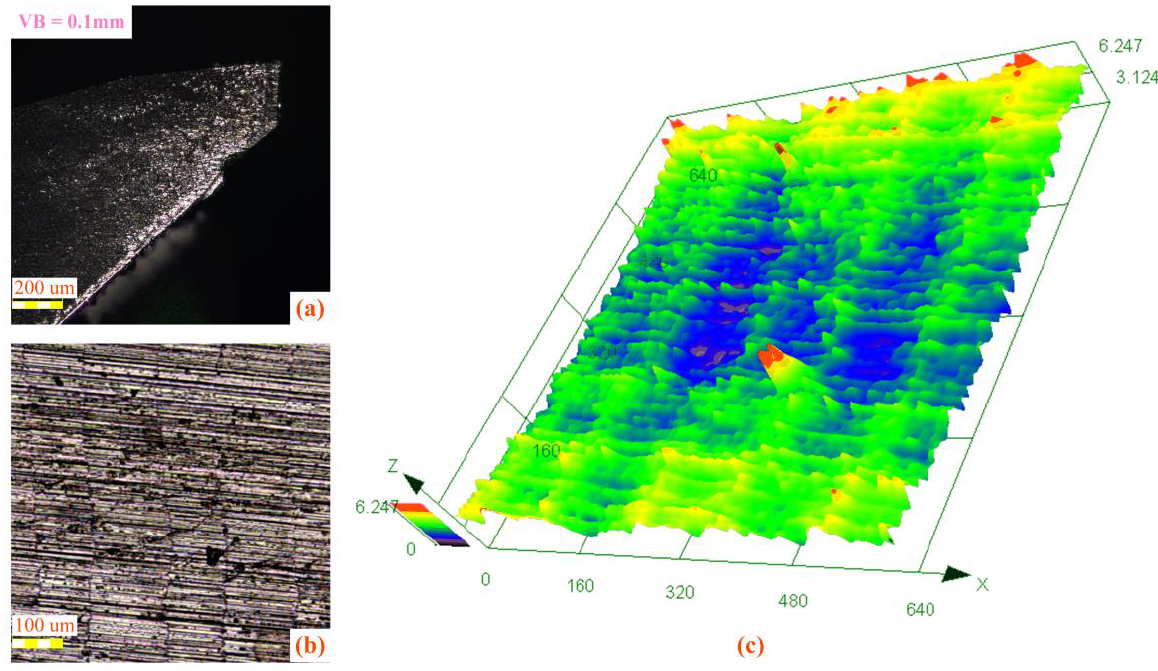
Figure 14. The surface topography of the machined workpiece, ( a ) tool wear, ( b ) two-dimensional topography, and ( c ) three-dimensional topography.